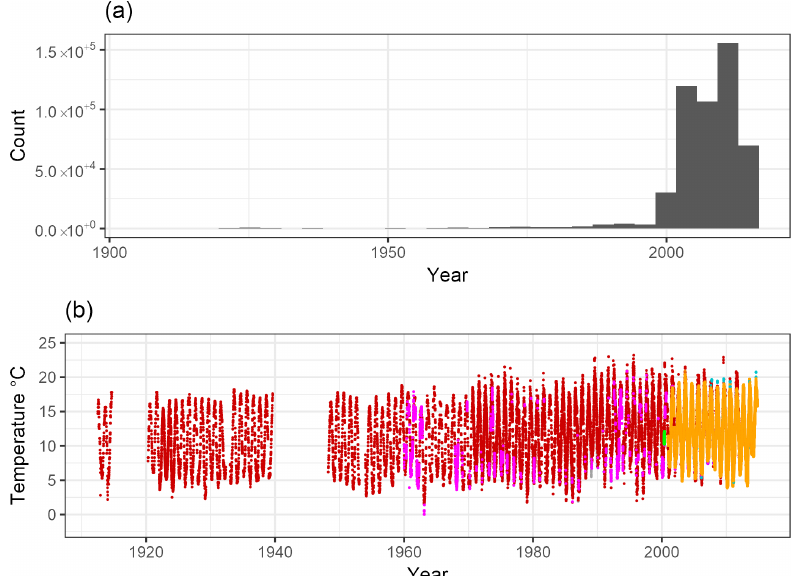
Figure 10. (a) Near-surface (0–5m) data counts in the southern North Sea. (b) Seawater temperature in the southern North Sea by year and data source. Blue: sources 8 and 15 (vessel-mounted pumped systems), green: sources 3, 4, 11, 16, and 17 (other source), and red: sources 6 and 7 (autonomous